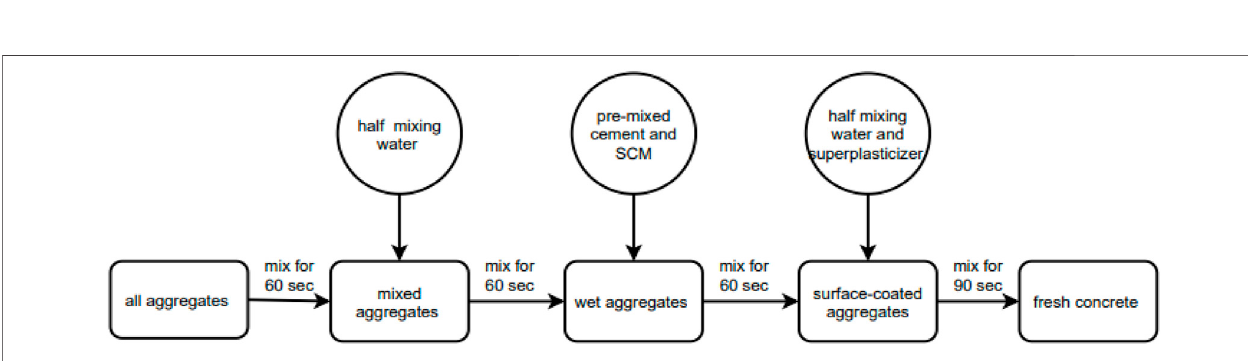
FIGURE 4 | Particle size distribution of blended fi ne aggregates. For referencing purposes, the mixes are denoted as X-Y-Z.